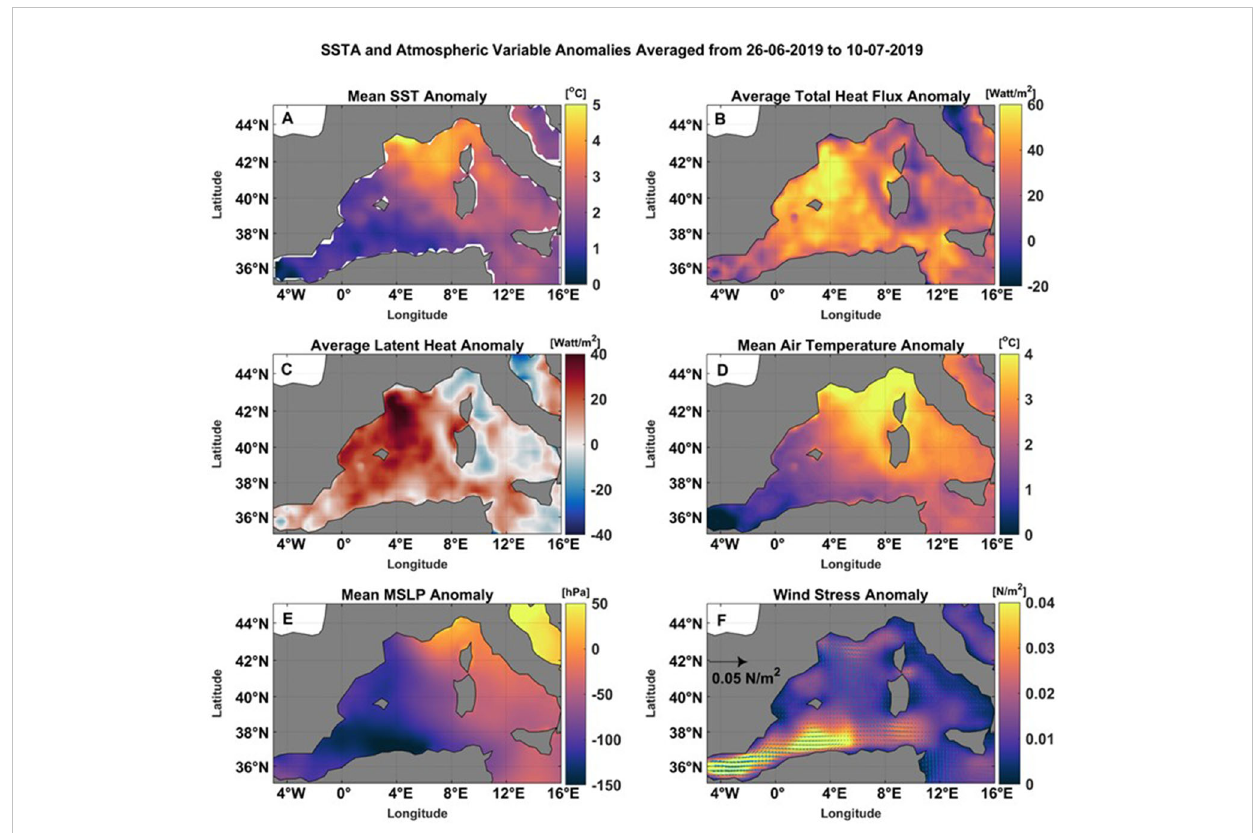
FIGURE 10 The mean (A) SST anomaly [°C], (B) total heat fl ux anomaly [W/m 2 ], (C) latent heat fl ux anomaly [W/m 2 ], (D) air temperature anomaly [°C], (E) mean sea level pressure anomaly [hPa], and (F) wind stress anomaly [N/m 2 ] during the MHW event (26 June-10 July 2019) in the WMB. Note that the anomalies were calculated based on 1982-2020 climatology from ERA5 hourly